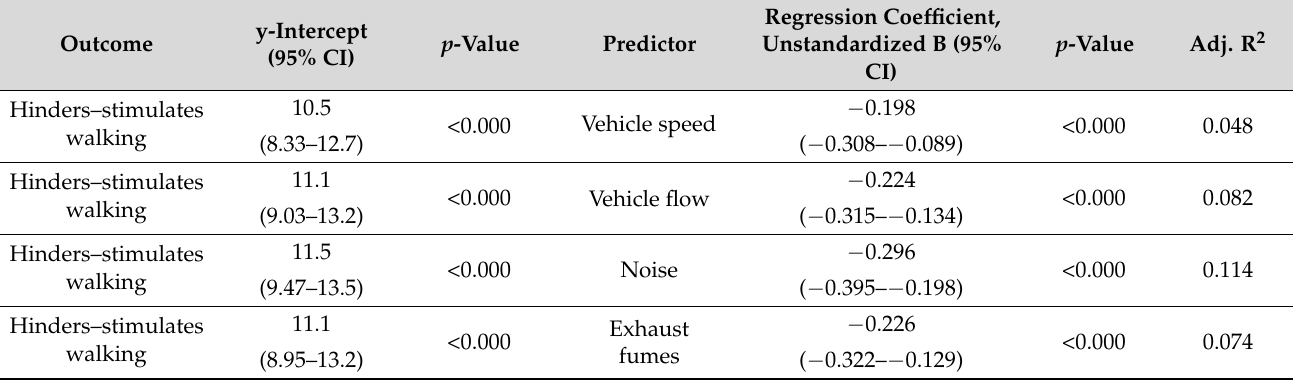
Table A5. Relations between the predictor variables and hinders–stimulates walking as an